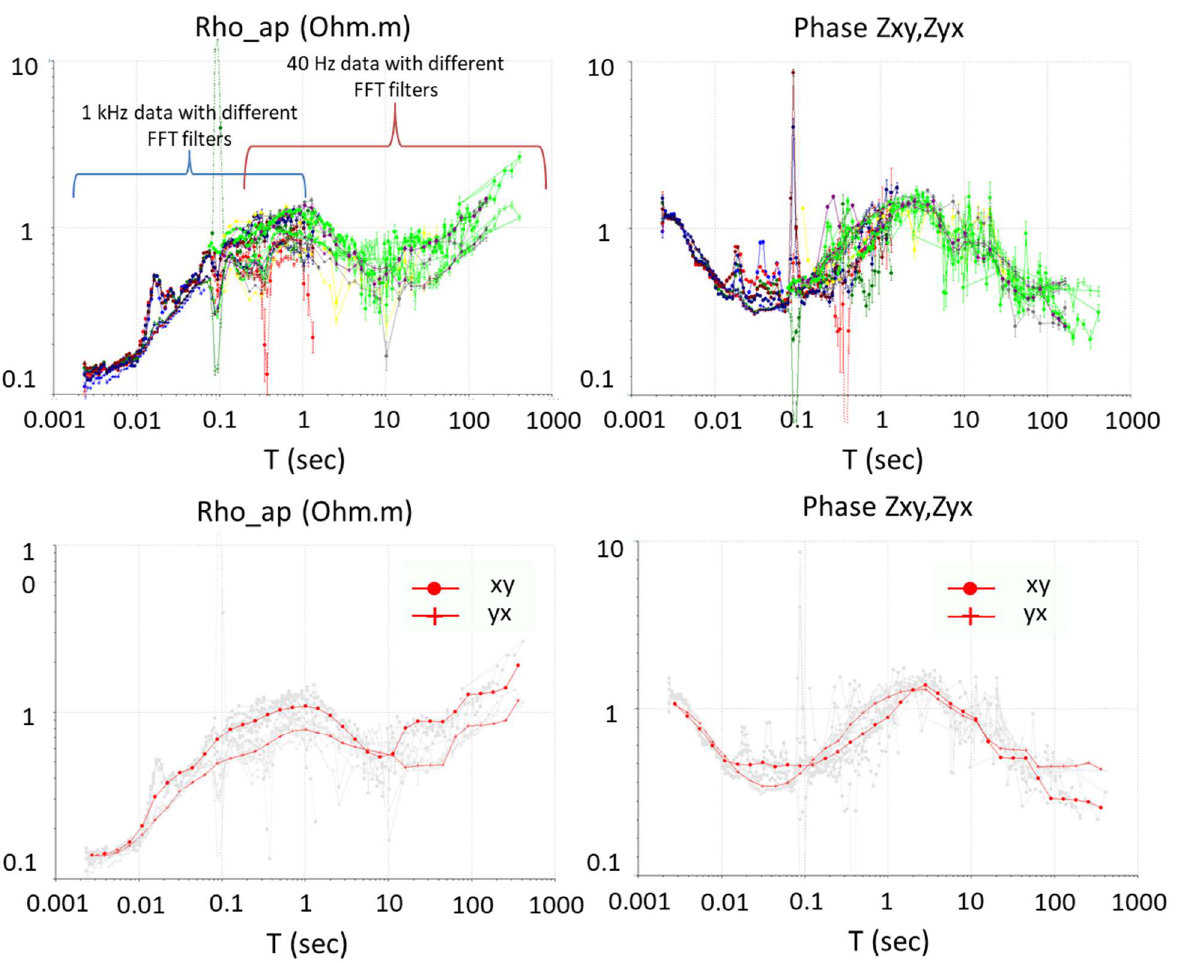
Figure 11. Apparent resistivity ( left ) and phase ( right ) vs. time plots for ST-02 for different (color- coded) sampling rate frequencies ( top ) and the calculated average ( bottom ).